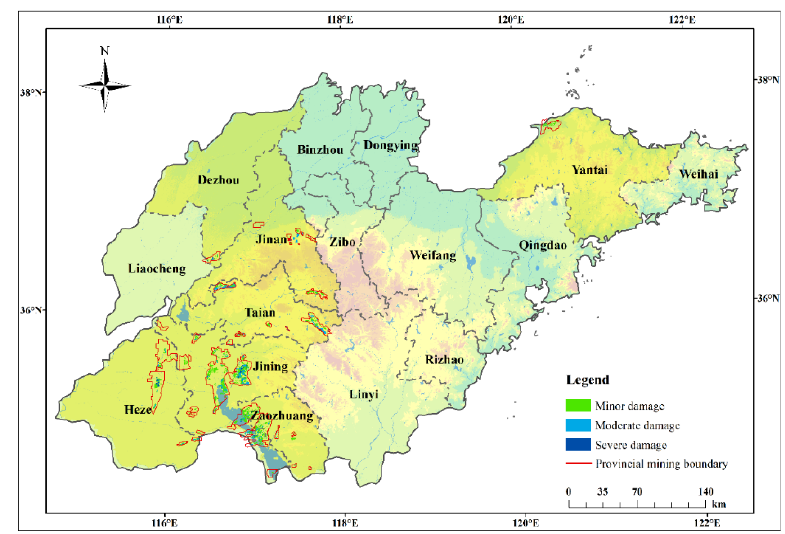
Figure 4. Prediction of mining subsidence land by 2025.